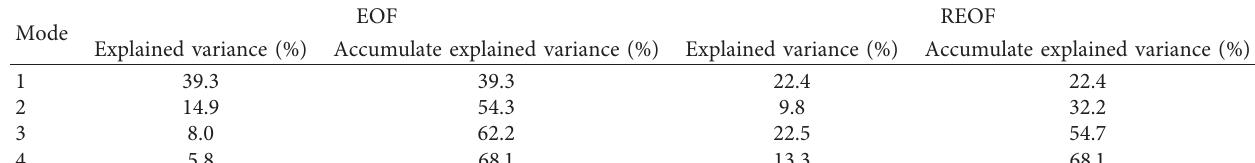
Table 4: The variance contribution of the first four EOF and REOF